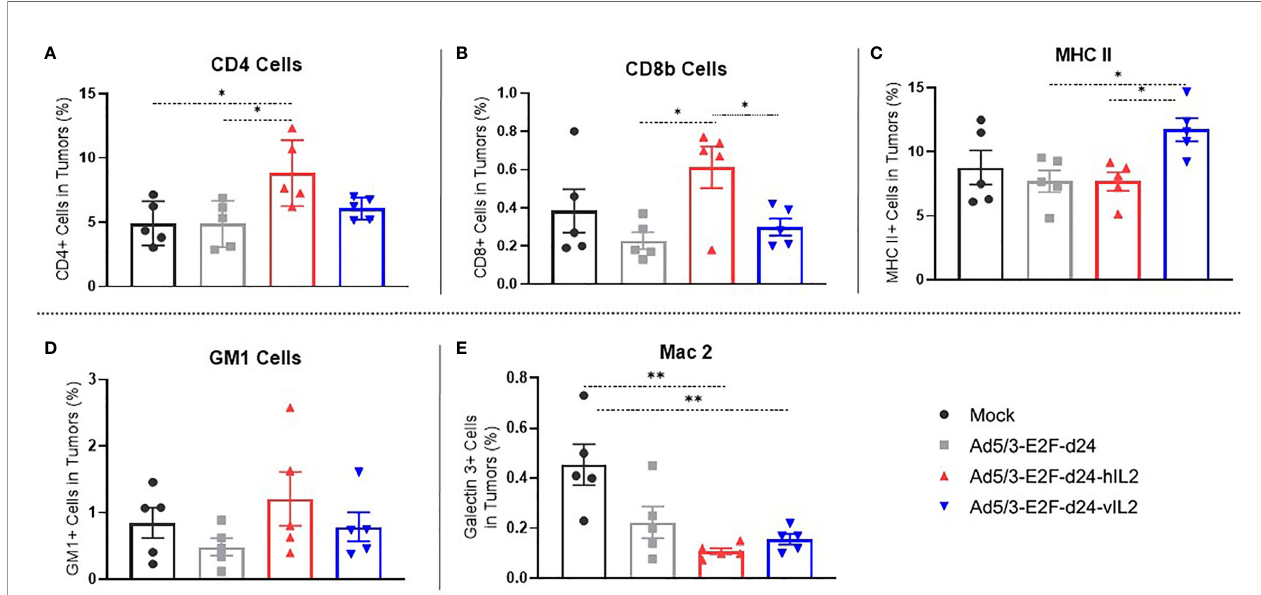
FIGURE 3 | Phenotype study of the immune cells constituting the microenvironment of treated tumors, by fl ow cytometry. The graphs show the percentage of (A) tumor in fi ltrating CD4+ T cells, (B) CD8+ T cells, (C) MHC II expressing cells, (D) natural killer cells, and (E) macrophages out of singlets. Data is presented as mean + SEM. *p < 0.05, and **p <